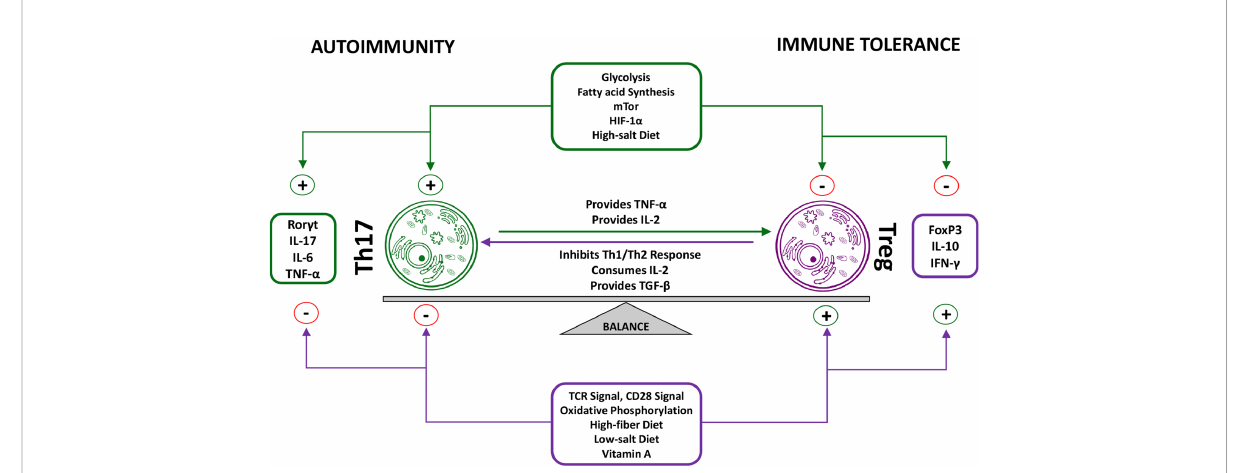
FIGURE 3 Reciprocal functions of Treg cells and Th17 cells. The balance between Treg cells and Th17 cells is of great importance for proper immune functioning. A dysregulation of this balance in favor of the pro-in fl ammatory Th17 phenotype has been observed in RA patients. Although various factors in fl uence this balance through isolated effects on either Treg or Th17 cells, numerous factors have been identi fi ed that simultaneously take effect on both Tregs and Th17 cells. Furthermore, Tregs and Th17 cells also directly take effect on one another. Th17 functioning physiologically causes an increase in the Treg population, which in turn prevents overarching immune reactions through inhibition of Th17-speci fi c as well as other immune pro-in fl ammatory functions (15, 16,